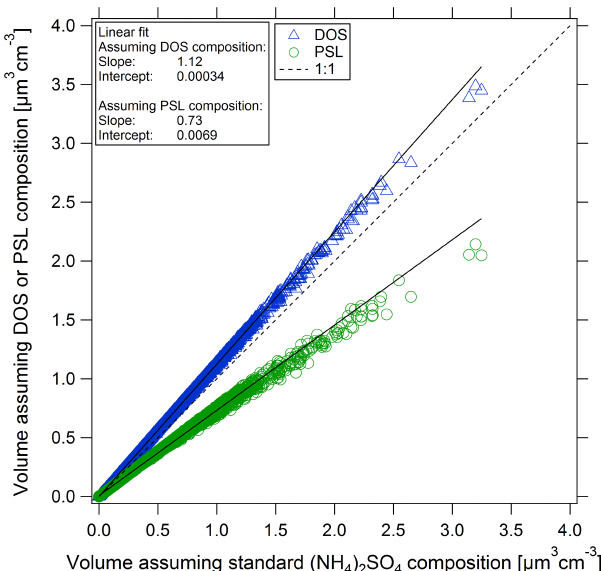
Figure 8. Comparison of the calculated aerosol volume from the UHSAS-2 measured dry size distributions based on calibration par- ticles with refractive indices between 1.44 and 1.58: (NH 4 ) 2 SO 4 ( n = 1.52), DOS ( n = 1.44), and PSL ( n = 1.58). Flight data shown (10 February 2017) are from 1s measurements. Solid lines repre- sent double-sided orthogonal distance regression linear